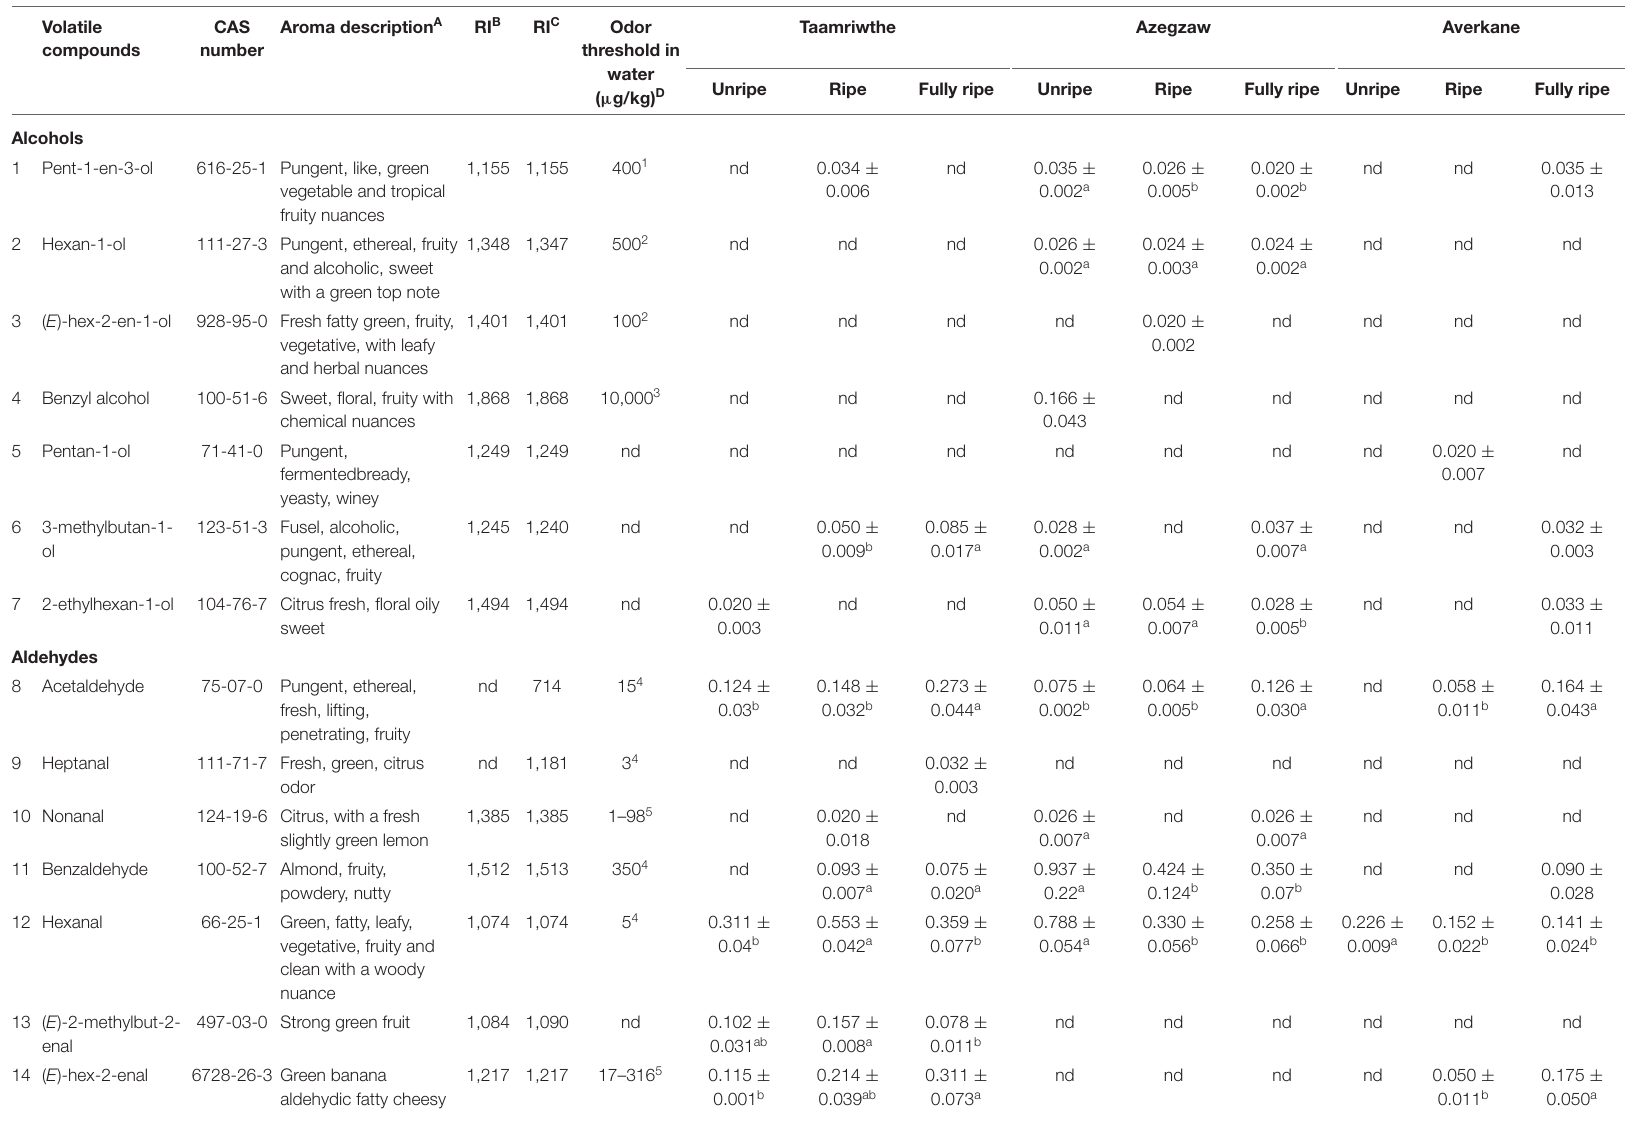
TABLE 1 | Volatile organic compounds (VOCs) identified by HS/SPME coupled with GC/MS during three ripening stages of different fig cultivars. Volatile